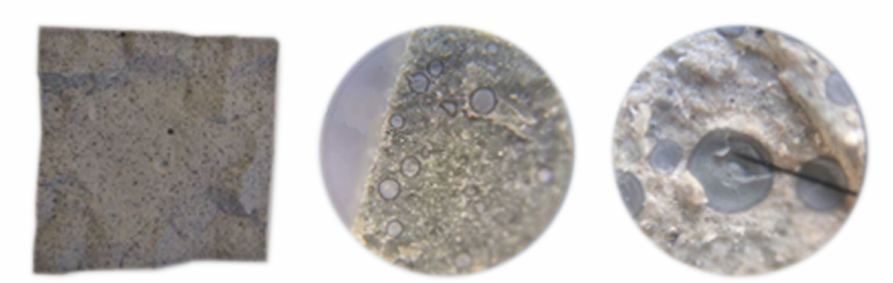
Figure 8. Cross-section and details of samples with SF (silica fume). The needle (black line) indicates an SF